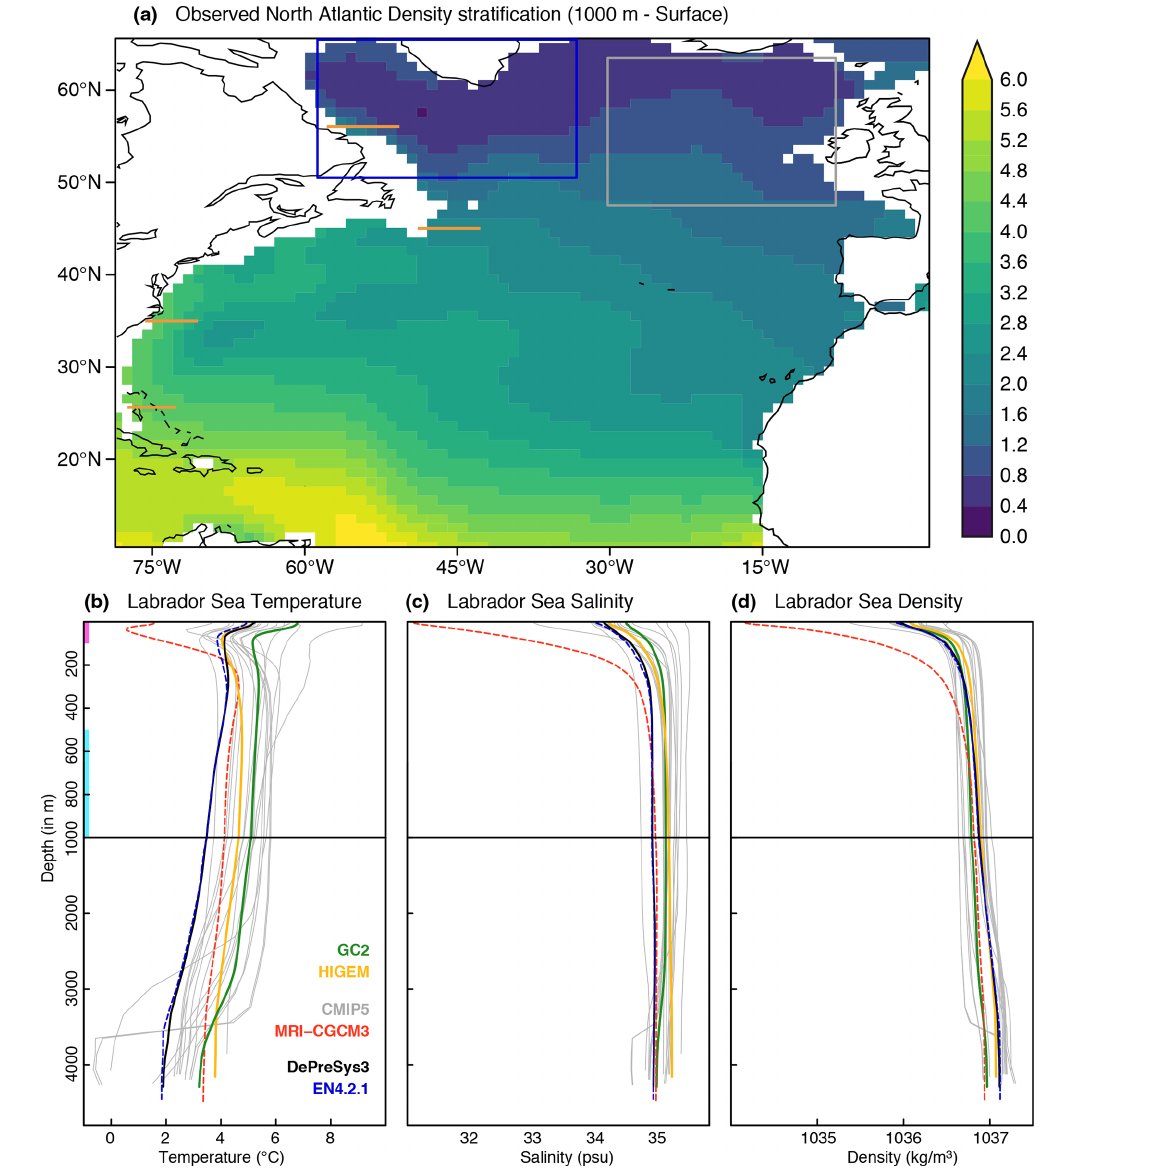
Figure 1. (a) Climatological density (computed as σ 2 at all depth levels) difference between the subsurface (1000m) and surface in the North Atlantic in the observational dataset EN4.2.1 (Good et al., 2013). The reference period to compute the climatology is 1960–2013. The grey box (32–10 ◦ W and 47–63 ◦ N) encloses the region where the ESPNA-T700 index in Fig. 4d is computed. (b–d) Climatological mean of the spatially averaged Labrador Sea (60–35 ◦ W, 50–65 ◦ N; blue box in a ) temperature, salinity, and density as a function of depth in the simulation ensemble, the DePreSys3 assimilation run, and EN4.2.1. The magenta (cyan) bars on the vertical axis correspond to the depths that have been used to define the vertical stratification Labrador Sea indices. The horizontal orange lines by the North American coast represent the location of the latitudinal cross sections in Figs. 10 and 11. For each model and dataset the climatology is computed for its whole length except for EN4.2.1, which is computed for the overlap period with the DePreSys3 assimilation